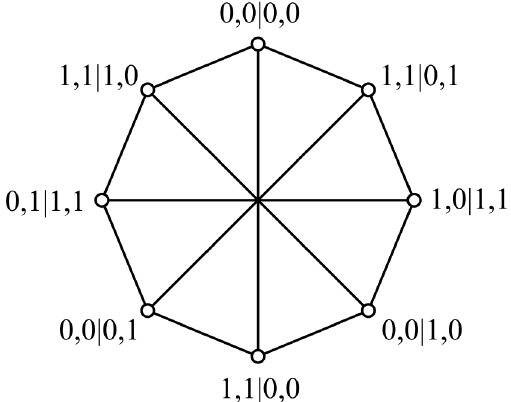
FIG. 1. Induced subgraph (of the 16-vertex graph of exclusiv- ity of the events in the CHSH scenario) corresponding to the eight events involved in the expression of the Bell witness given by Eq. (4). This graph is called the eight-vertex circulant graph ( 1, 4 ) and is denoted Ci 8 [1, 4] (see Definition 7 in Appendix A for a definition of circulant graphs), and is isomorphic to the Möbius ladder graph of order